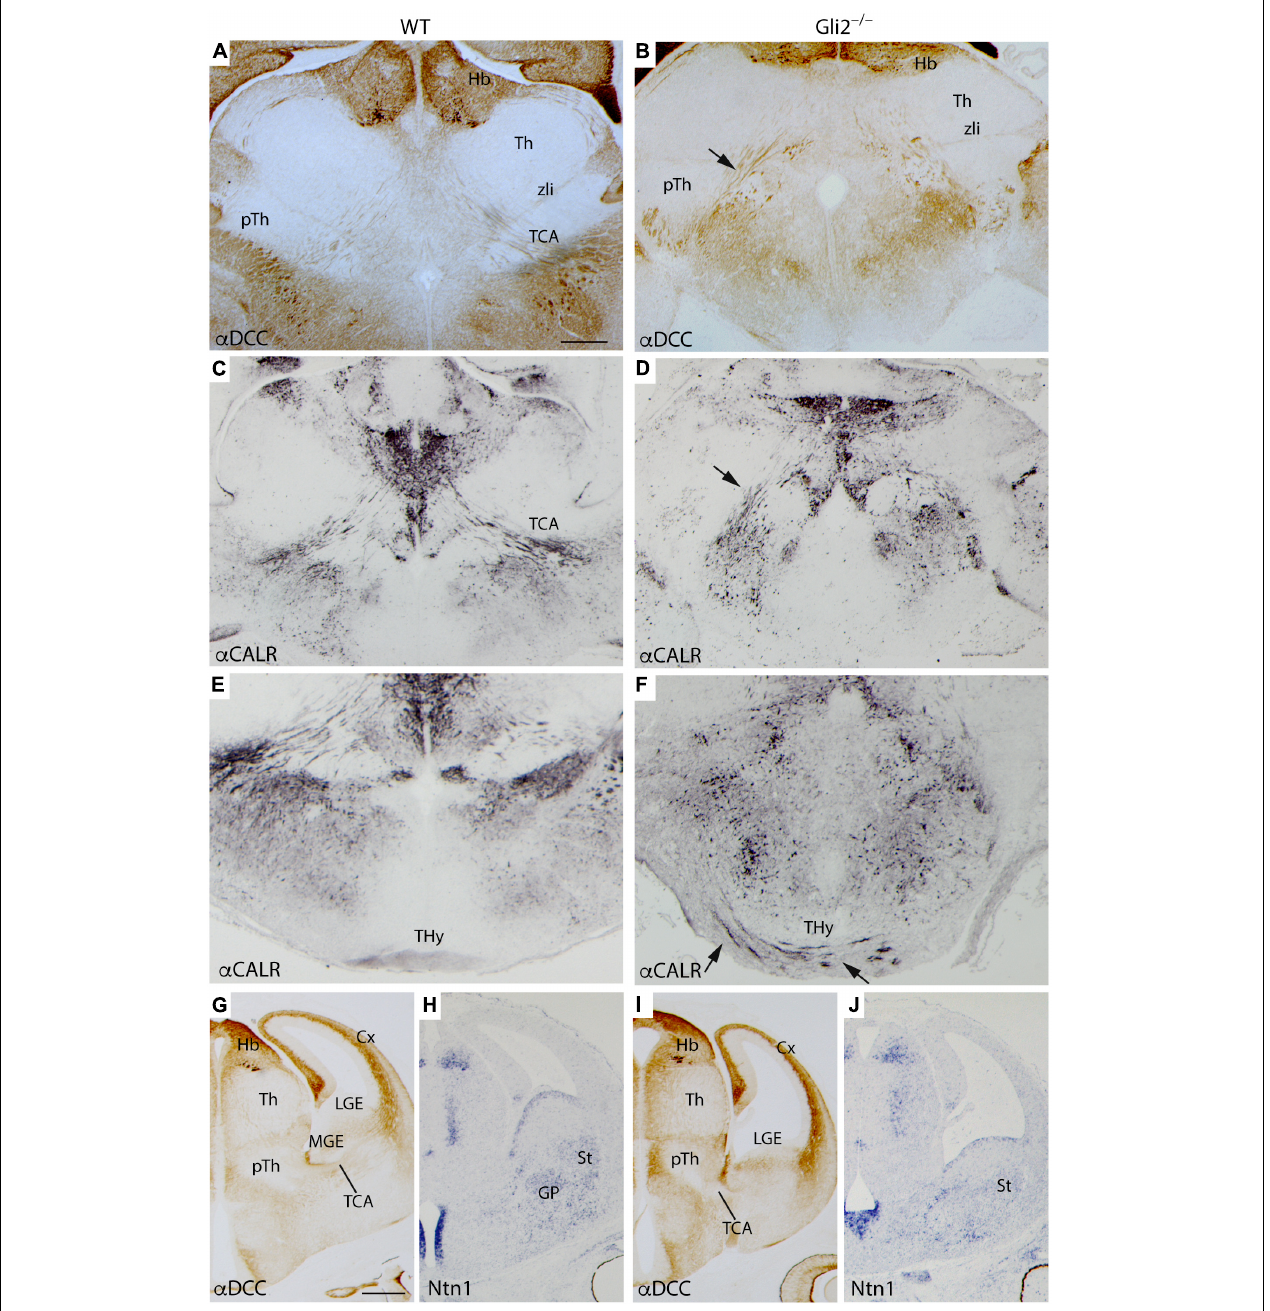
FIGURE 2 | TCAs aberrant trajectory in late- and mid-stage mutant embryos. Selected transversal sections through the forebrain of E18.5 WT (A,C,E) and Gli2 mutant (B,D,F) showing immunohistochemistry for α -DCC (A,B) revealed with DAB and α -Calr revealed with DAB plus nickel (C–F) . The mutant TCAs followed an aberrant trajectory crossing the PHy and the THy [arrow in (B,D) ] reaching the midline in the basal hypothalamus [arrows in (F) ]. Coronal sections of E12.5 WT (G,H) and Gli2 mutant (I,J) labeled by immunohistochemistry against DCC (G,I) and by in situ hybridization for Ntn1 (H,J) . Cx, cortex; DCC, Deleted in colon carcinoma; Hb, Habenula; THy, terminal hypothalamus; GP, globus pallidus; LGE, lateral ganglionic eminence; MGE, medial ganglionic eminence; pTh, prethalamus; St, striatum; TCA, thalamocortical axons; Th, thalamus; zli, zona limitans. (A–F) Scale bar: 200 µ m; (G–J) scale bar: 300 µ m.